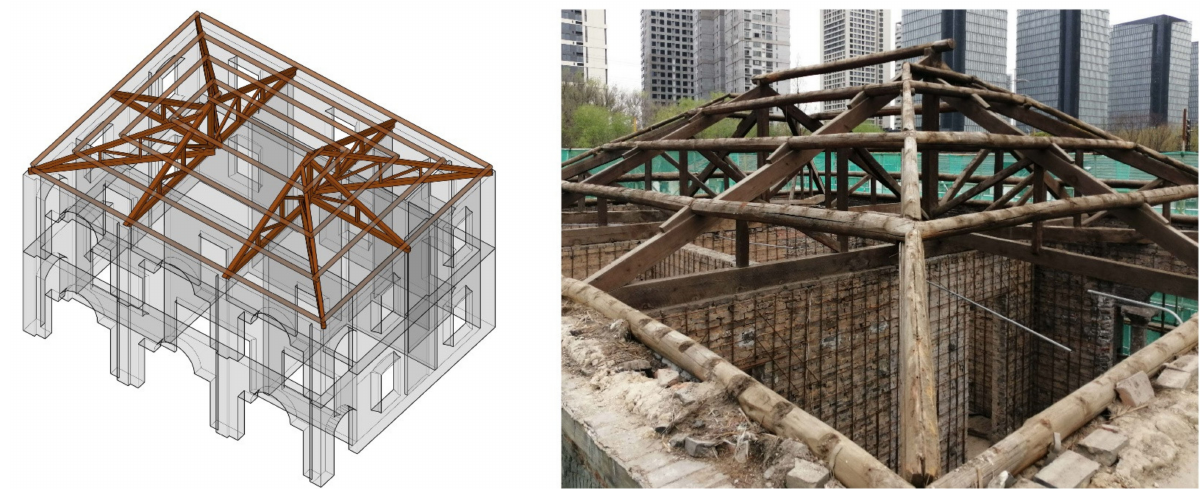
Figure 20. The Western triangular roof-truss system of the Priest’s